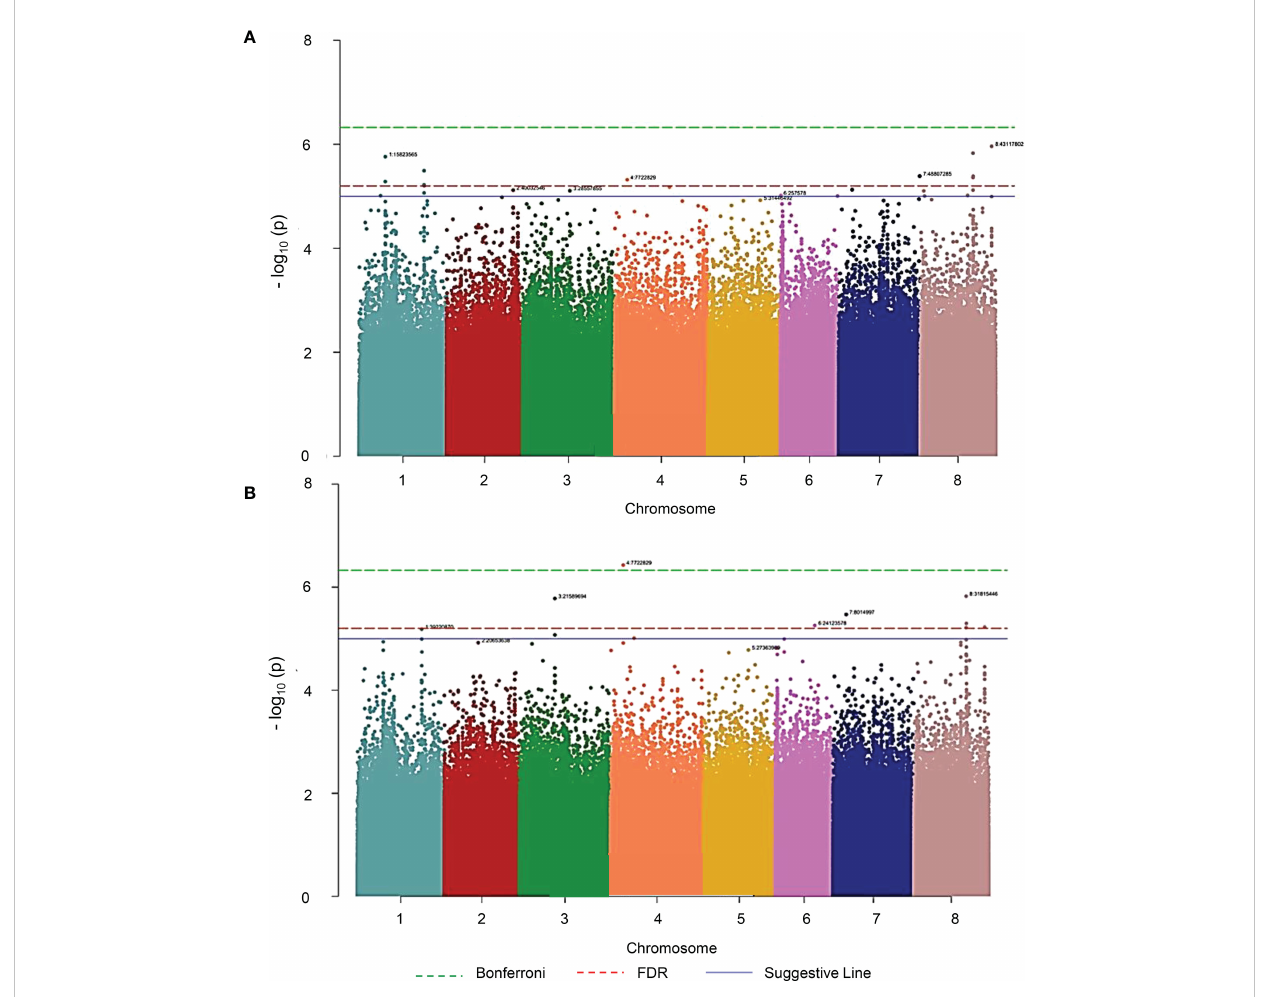
FIGURE 6 Manhattan plot illustration of the response of M. truncatula to V. alfalfae strain AF1 revealed by GWAS analysis. (A) AUDPC, (B) MSS. The green dashed line represents the Bonferroni threshold, the red dashed line the FDR threshold and the blue solid line the suggestive line of the qqman R package. AUDPC and MSS phenotypes were evaluated in 242 root-inoculated accessions of the MtHapMap collection. Association genetic analysis was performed using a Mixed linear model - Q Model. Each point represents a SNP. The X-axis shows the 8 chromosomes ordered by number, the Y-axis represents the association score, i.e. the probability that the SNP is related to the studied phenotype, is calculated as